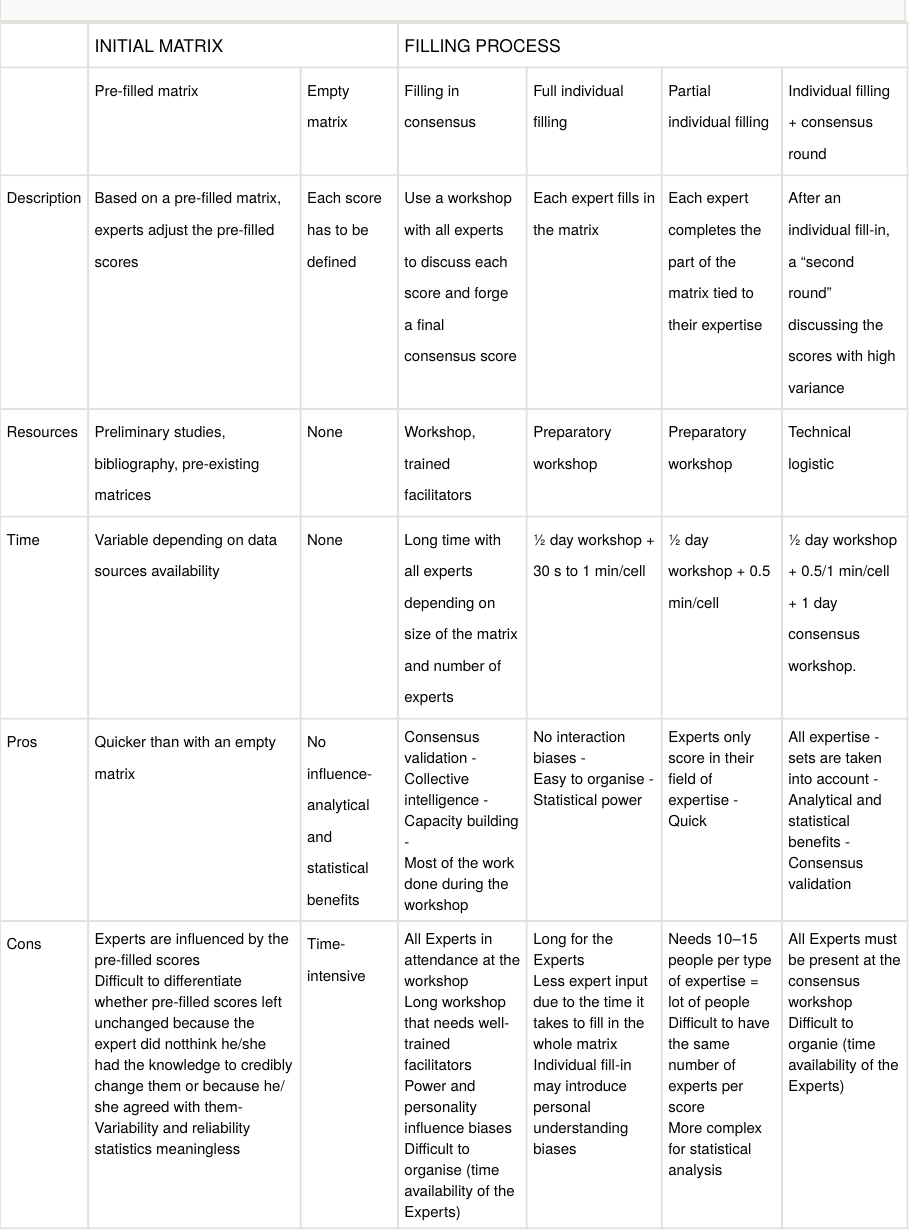
Description Based on a pre- fi lled matrix, experts adjust the pre- fi lled